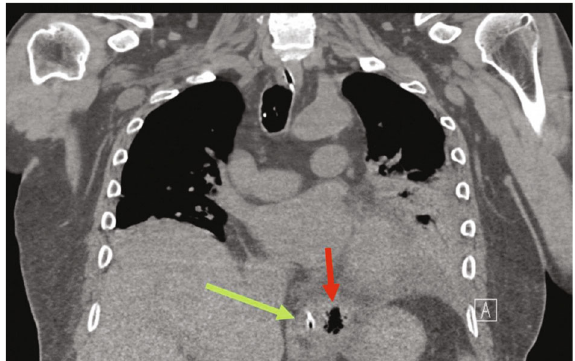
Figure 2: Noncontrasted coronal CT images showing a pocket of air in the mediastinum left lateral to the esophagus (red arrow) consistent with esophageal perforation. Green arrow identi fi es an NG tube within the esophageal